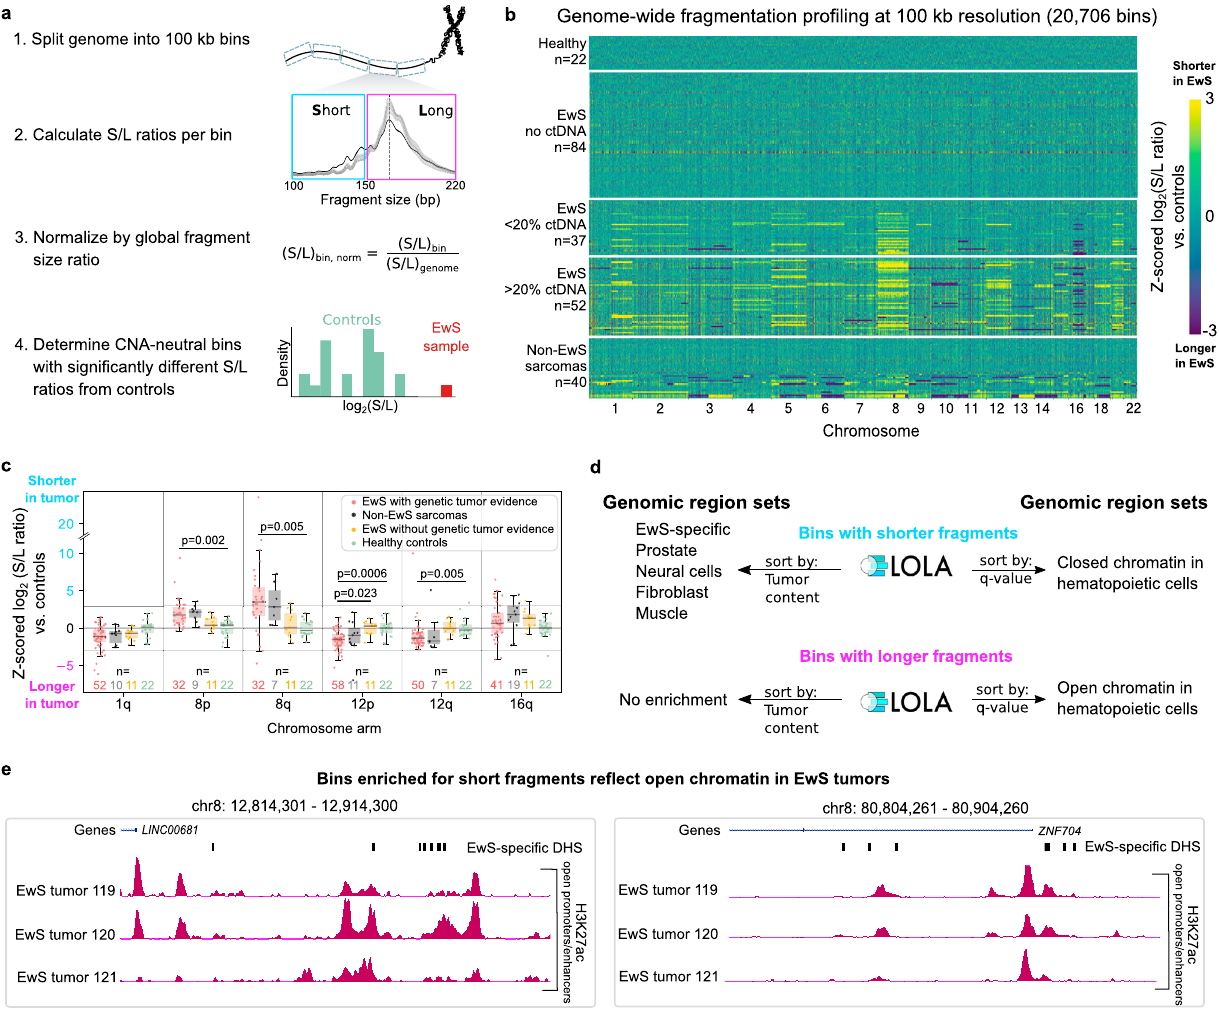
Fig. 4 Regional fragment-size analysis detects an EwS tumor-speci fi c epigenetic signature in cfDNA samples. a Schematic illustration of the regional fragment-size analysis, measuring the ratio of short (S) versus long (L) cfDNA fragments in 100 kb bins along the genome. Genomic regions that overlap with CNAs are excluded in order to focus the analysis on epigenetic signatures re fl ected in the cfDNA fragmentation patterns. b Heatmap comparing the genome-wide fragmentation pro fi les of cfDNA samples from patients with pediatric sarcoma to those of healthy controls. In each 100 kb bin ( n = 20,706 bins), the log 2 (S/L ratio) of each sarcoma sample was compared to the distribution of log 2 (S/L ratios) of healthy controls via z -scores. Both CNA-affected and CNA-neutral bins are shown. EwS samples are grouped by genetically inferred tumor-derived DNA content. c Regional cfDNA fragmentation in patients with pediatric sarcoma compared to healthy controls. Only chromosome arms that are recurrently affected by CNAs in EwS tumors are shown. Box plots illustrate z -scores for EwS samples with genetic tumor evidence and without detected CNAs on the chromosomal arm (red), non-EwS sarcomas with genetic tumor evidence and without detected CNAs on the chromosomal arm (black), EwS samples without genetic tumor evidence (yellow), and healthy controls (green). The signi fi cance of the fi rst group versus each of the other three groups was assessed using the two-sided Mann – Whitney U test; Bonferroni-corrected p -values are shown. Boxes correspond to interquartile ranges (IQR), thick black lines indicate the median, and the whiskers extend to the lowest or highest data point that are still within 1.5 IQR of the bottom or top quartile, respectively. d Functional enrichment analysis for regions with signi fi cantly shorter/longer cfDNA fragment size compared to healthy controls based on the LOLA software 54 . A selection of enriched terms is shown, while the full list is provided in Supplementary Data 6. e EwS tumor-speci fi c epigenome pro fi les for selected regions with signi fi cantly shorter cfDNA fragment size compared to healthy controls. The genome browser pro fi les show open chromatin-associated histone H3K27 acetylation (for regions with shorter fragments) based on ChIP-seq data for primary EwS tumors 41 . EwS-speci fi c DHSs along the selected genomic region are also